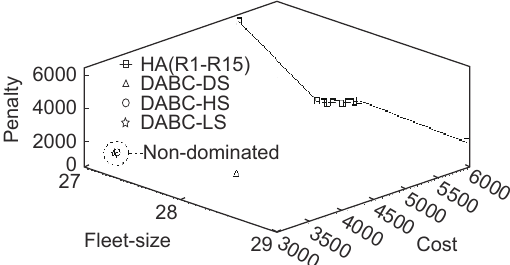
Fig. 10 Schedules produced by DABC and HA in terms of three